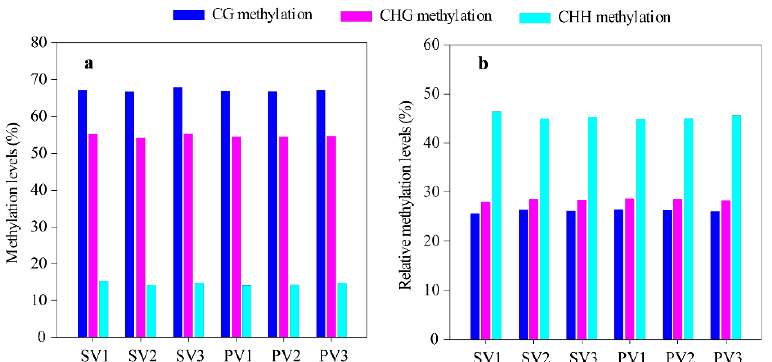
Figure 1. The methylation levels in pecan grafts. SV1, SV2, SV3: grafts with strong growth vigor; PV1, PV2, PV3: grafts with poor growth vigor. ( a ) Methylation level was determined based the number of methylated cytosines ( m C) of each context/the number of all C sites of the same C context; ( b ) Relative methylation level represented the percentage of methylated CG, CHG or CHH among all methylated cytosines (H = A, T, or C).